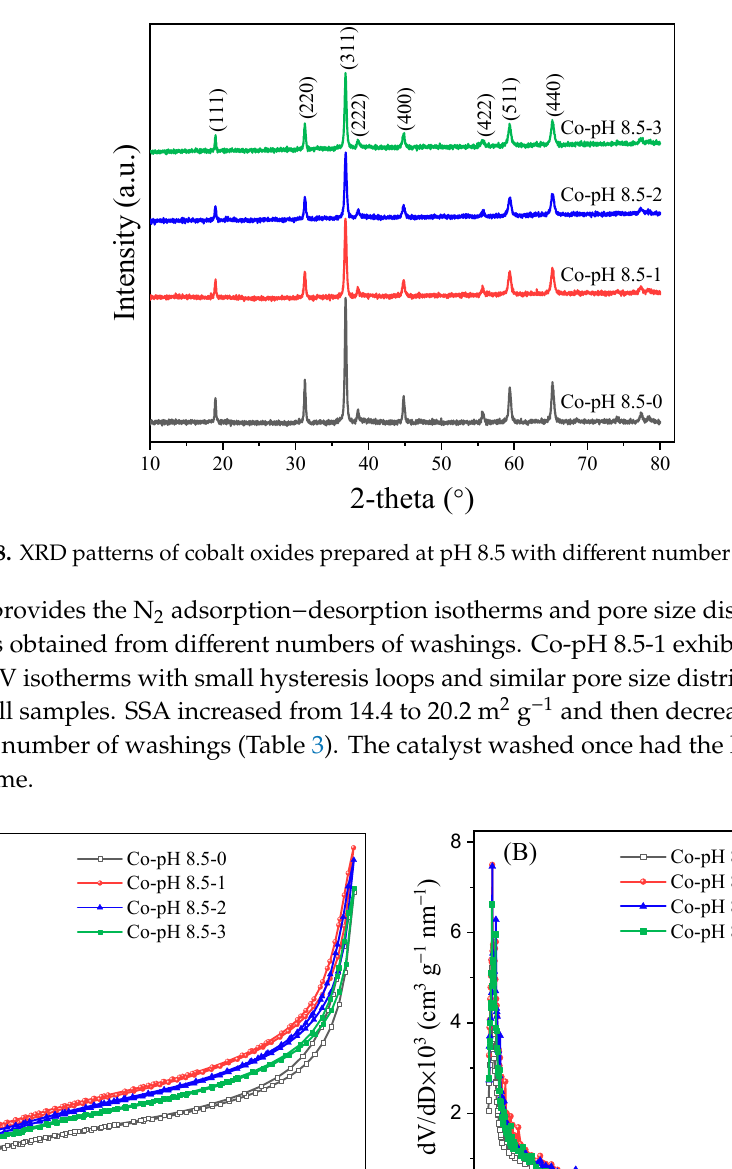
Figure 8. XRD patterns of cobalt oxides prepared at pH 8.5 with different number of washings. Table 3. Product yields, crystalline sizes, lattice constants and textural of cobalt oxides prepared at pH 8.5 with different number of washings.